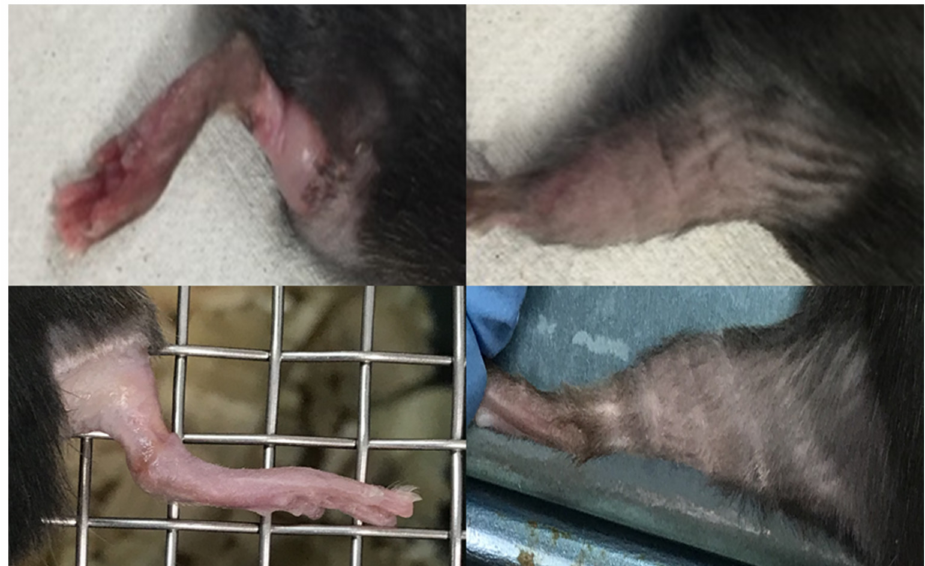
Figure 6. Photographs of skin responses. Upper row: skin response two weeks after irradiation. Left: mouse’s leg irradiated with Ne broad beam, showing moist desquamation and ulceration. Right: leg of mouse two weeks after receiving Ne MBRT, exhibiting erythema. Lower row: mice’s legs four weeks after irradiation. Left: mouse’s leg irradiated with Ne broad beam, exhibiting extensive damage. Right: leg of one mouse in the MBRT group showing how the skin has almost recovered.